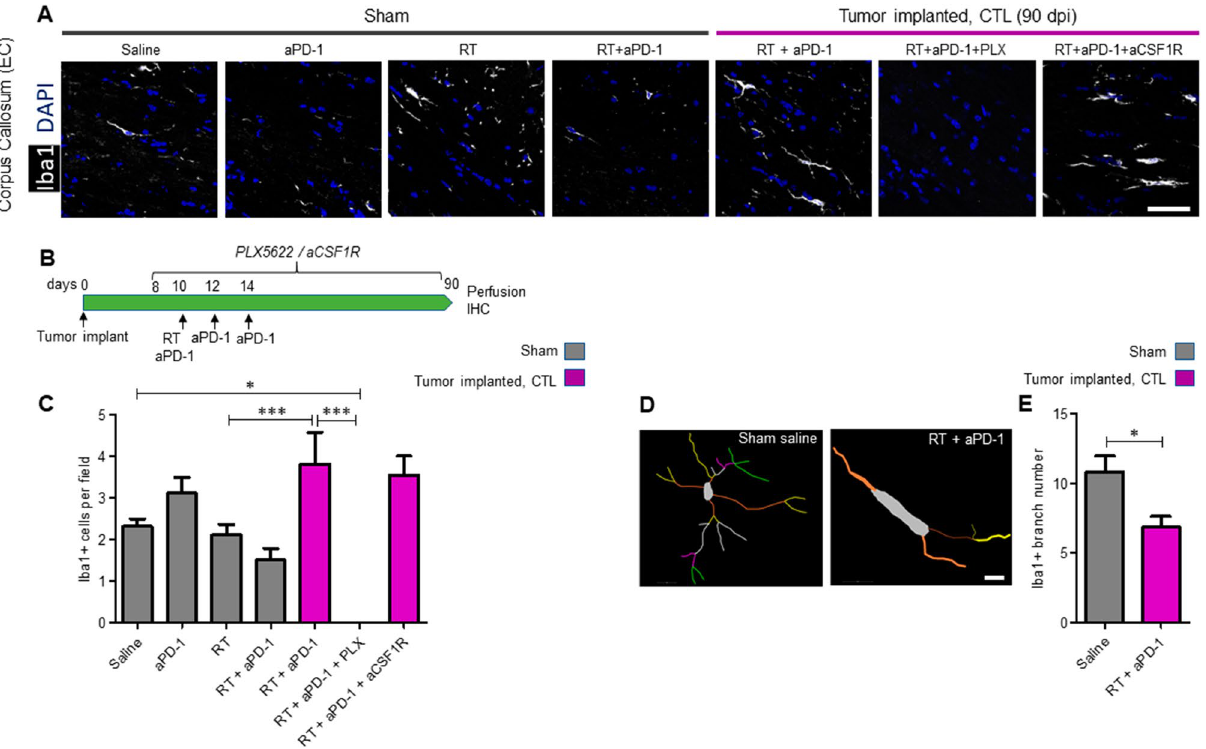
Figure 2. Tumor implanted mice treated with radiation in combination with aPD-1 showed chronic activation of microglia. ( A ) Sham operated mice were treated with either saline, aPD-1, RT or combined RT + aPD-1. Tumor implanted mice were treated with RT + aPD-1 plus either saline, PLX5622 or anti-CSF1R. Samples were collected at 90 dpi. Representative images of Iba1 IHC stain in the external capsule of the corpus callosum (EC) from the hemisphere contralateral to the implantation site (CTL) are shown. Scale bar = 50 µm. ( B ) Schematic of the experimental design for microglia elimination with PLX5622 and blockade of peripheral macrophages with anti-CSF1R blocking antibody in tumor implanted mice treated with RT + aPD-1. ( C ) Quantification of the numbers of Iba-1 cells in the EC of sham and tumor implanted mice. n = 6 per treatment arm in sham mice and n = 6 RT + aPD-1 + saline, n = 3 RT + aPD-1 + PLX5622 and n = 3 RT + aPD-1 + aCSF1R in tumor implanted mice, * P < 0.05, *** P < 0.001 by ANOVA followed by Tukey’s post hoc t test. ( D ) Fluorescent images of Iba1 + cells from sham mice and RT + aPD-1 treated tumor implanted mice were traced in Neurolucida software (https ://www. mbfbi oscie nce.com/neuro lucid a). Scale bar = 10 µm. ( E ) 3D reconstructions from the tracings were analyzed using the linear Sholl analysis method. The total number of branches per cell was significantly reduced in RT + aPD-1 treated tumor implanted mice. n = 3 per group, * P < 0.05 by Student’s t